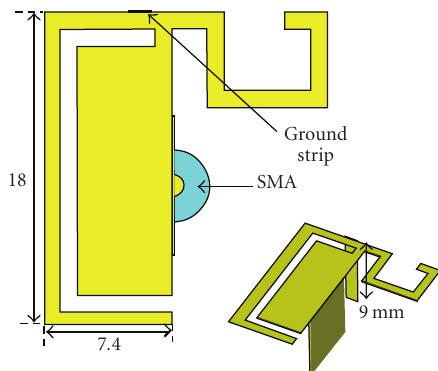
Figure 4: Photos of the tri-band antenna with a 10 cm × 6 cm